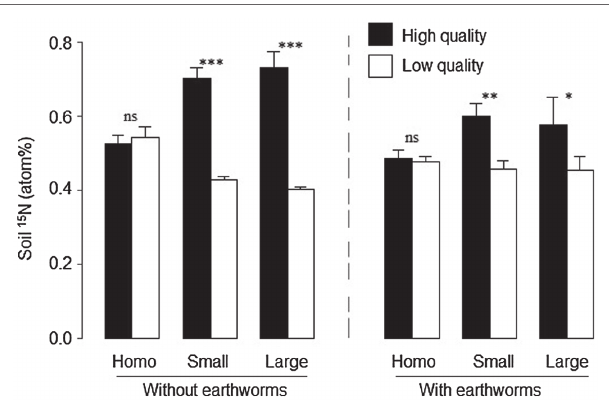
FIGURE 4 | Soil 15 N in the high- and low-quality patches in the heterogeneous small patch and large patch treatments and in the imagined high- and low-quality patches in the homogeneous treatments with and without earthworms. Mean ± SE ( n = 6) are given. Symbols above pairs of bars shows levels of differences between the high- and low-quality patches (*** p < 0.001, ** p < 0.01, *p < 0.05 and ns p > 0.05; by linear